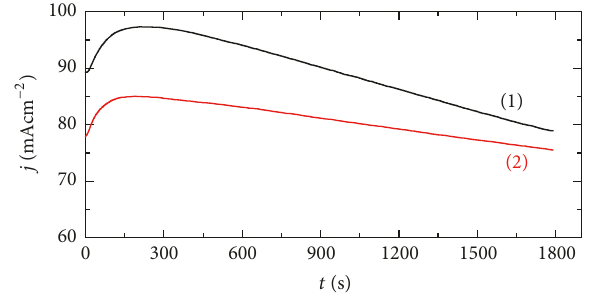
Figure 5: Chronoamperometric curves obtained for ( 1 ) Fe-36% Ni and ( 2 ) Fe-45% Ni immersed in 1M HCl solutions for 2400 s followed by stepping the potential to +0.150V versus